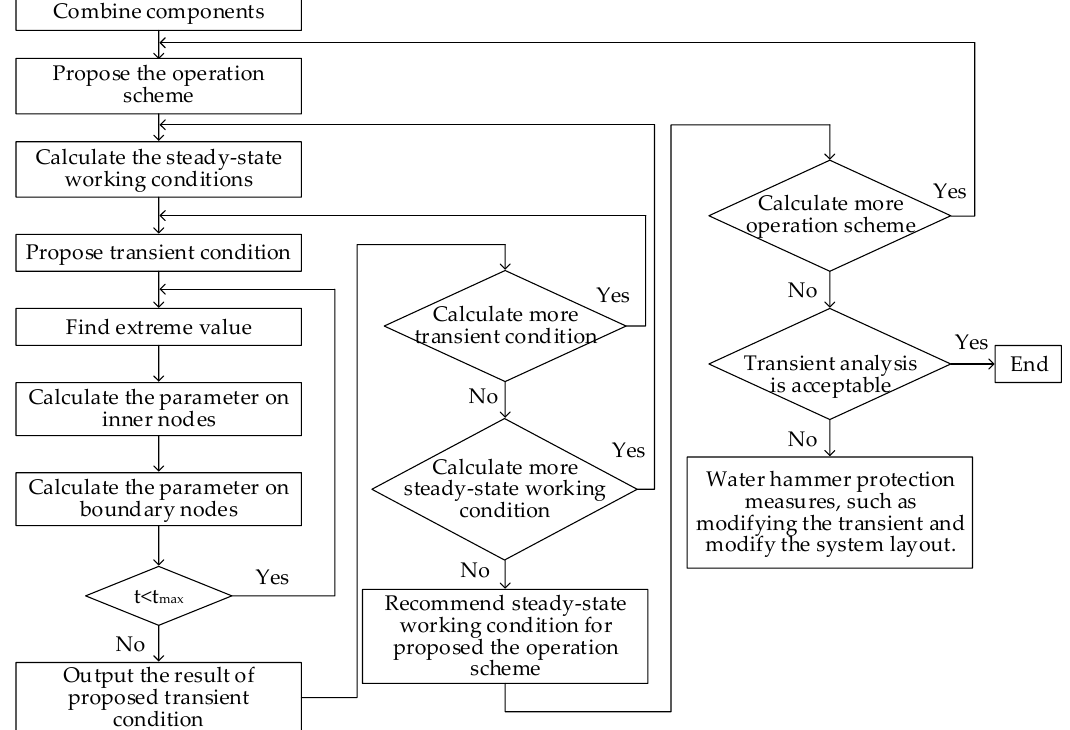
Figure 4. A flow chart for the numerical simulation procedure for complex water transfer systems using the method of characterizations (MOC).